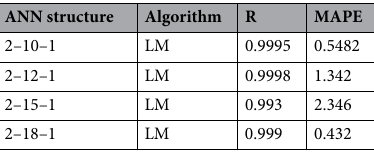
Table 5. Correlation coefficient and mean absolute error values for ANN structure.